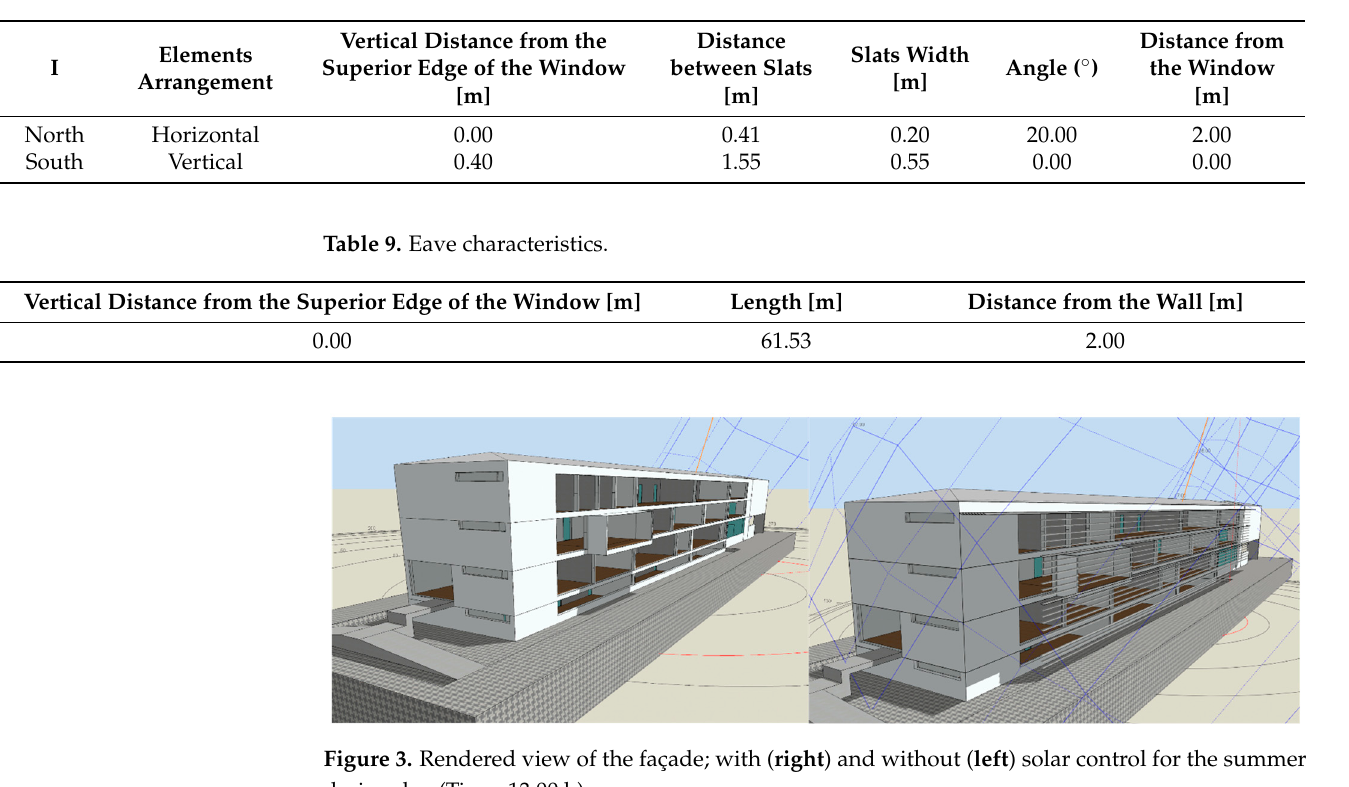
Figure 4. Rendered view of south façade; with ( right ) and without ( left ) solar control for the summer design day (Time: 16:30 h).